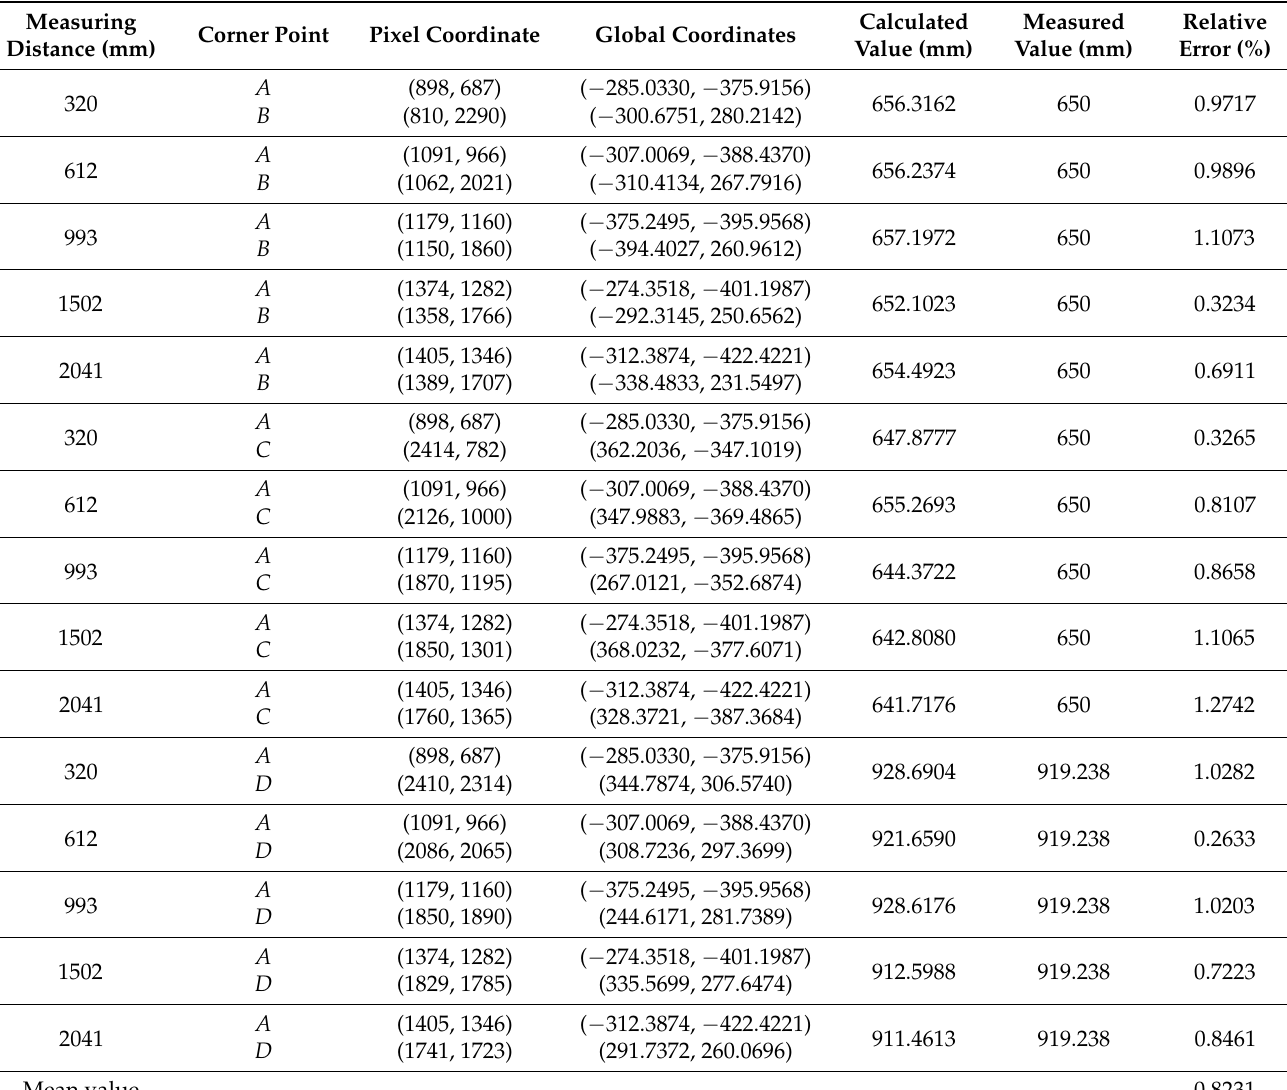
Figure 7. Corner point position selection and calibration plate position selection. ( a ) Corner point position, A , B , C , and D are corner points; ( b ) Five positions of the calibration plate. Three sets of distances, AB , AC , and AD , were taken on the chessboard, the error was analyzed, and the accuracy of the measurement model was verified. Table 1 shows the calculation results of the distance between AB , AC , and AD . Table 1. AB , AC , AD calculation